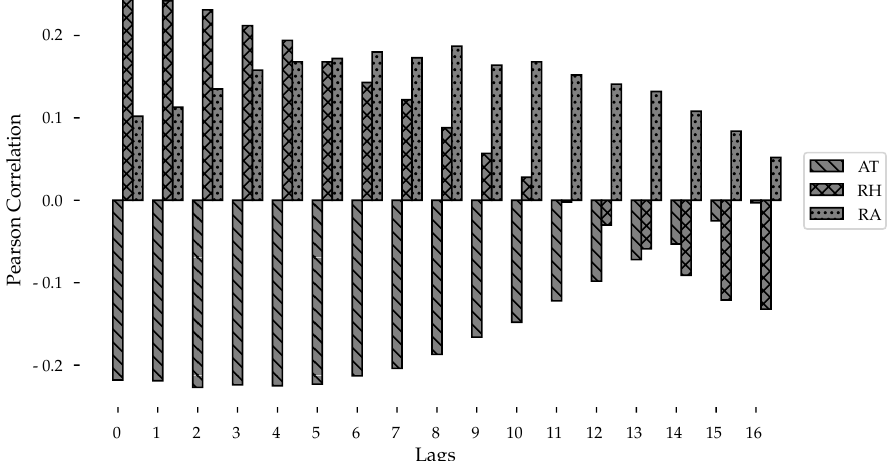
Figure 11. Variation in Pearson’s correlation coefficient as climatic variables are lagged.